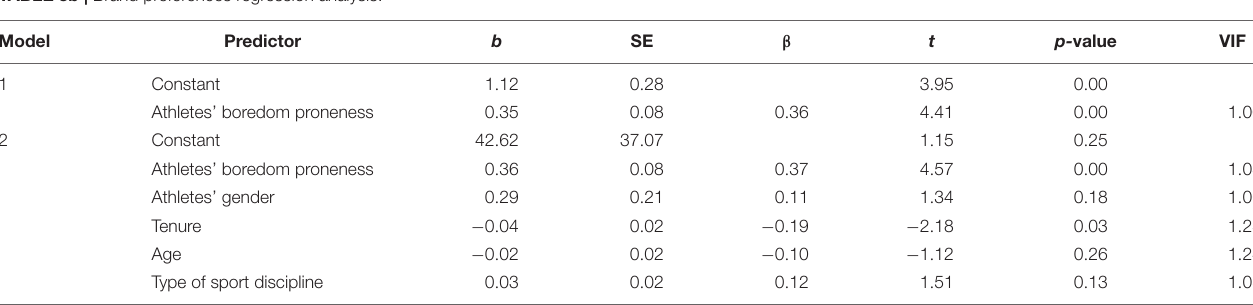
TABLE 3b | Brand preferences regression analysis. Model